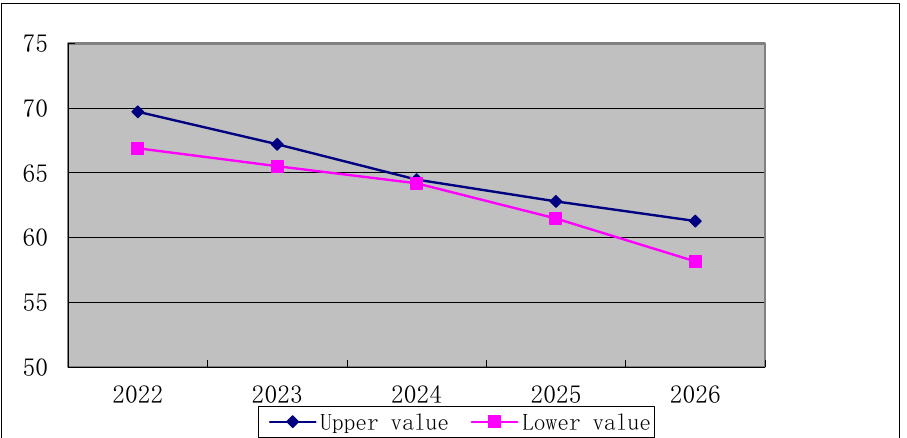
Figure 14. The variation interval of water requirement with the influence of primary industry in Shanxi Province.